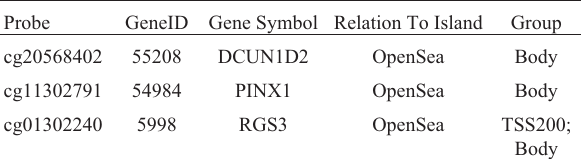
Table 1 - Detailed information of three methylation markers (probes) for LUAD